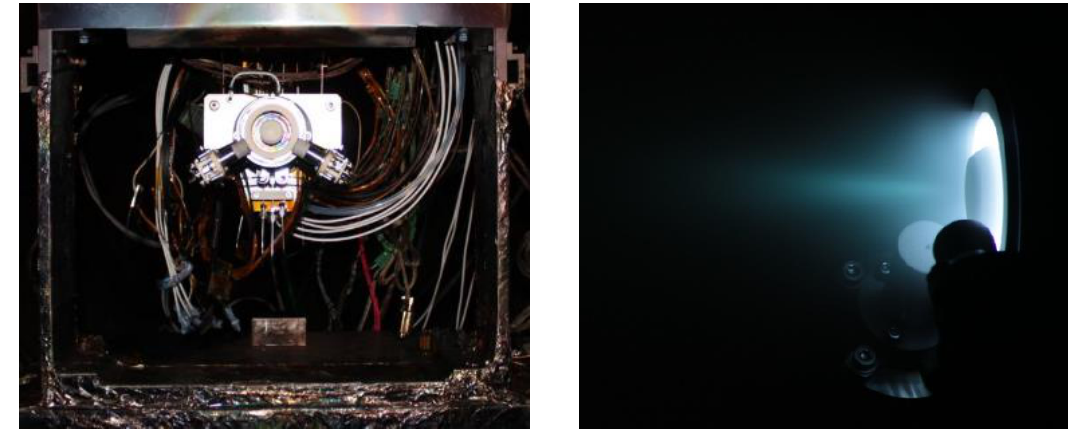
Figure 10. Thruster unit (TU; HT100 and two HC1 cathodes) mounted on the thrust balance (left) and during a coupling test (right).